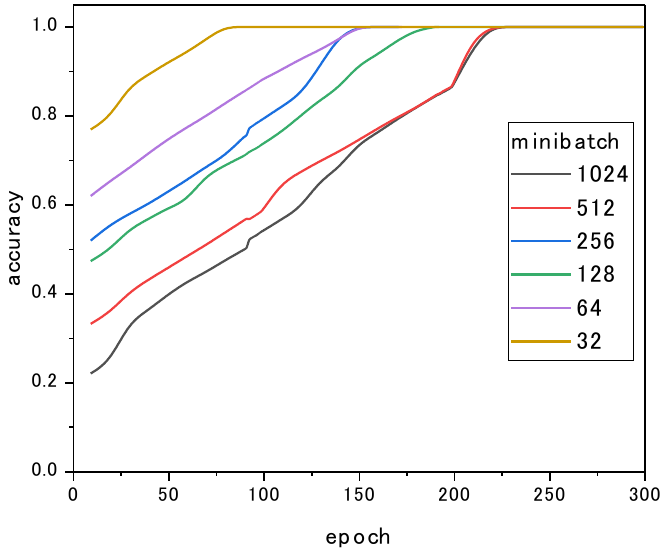
Figure 4. Accuracy of different Minibatch sizes.